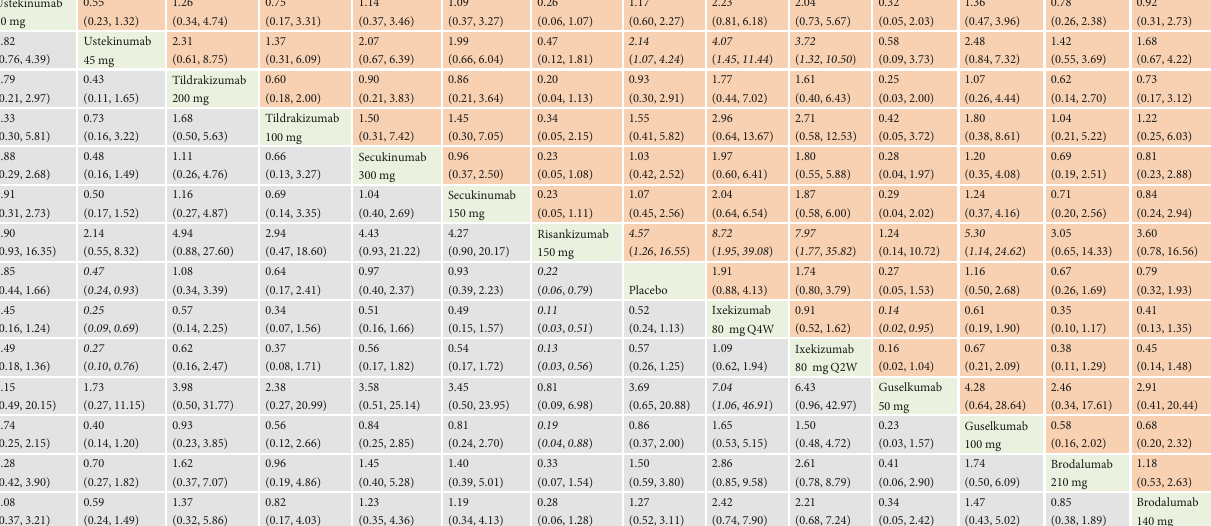
Figure 9: Relative risk with 95% CIs of all interventions from network meta-analysis for Discontinuations due to AEs. Di ff erent interventions in the middle block divide the graph into upper and lower triangles; for the lower triangle, the e ffi cacy estimate is the ratio of the column de fi ning treatment to the row de fi ning treatment. In case that the con fi dence interval does not include 1, if RR > 1 , it favors the row de fi ning treatment. In contrast, if RR < 1 , it favors the column de fi ning treatment. The upper triangle is symmetrical to the lower triangle. The e ffi cacy estimate is the ratio of the row de fi ning treatment to the column de fi ning treatment. The results are mutually reciprocal. Statistically signi fi cant results have been applied with italic